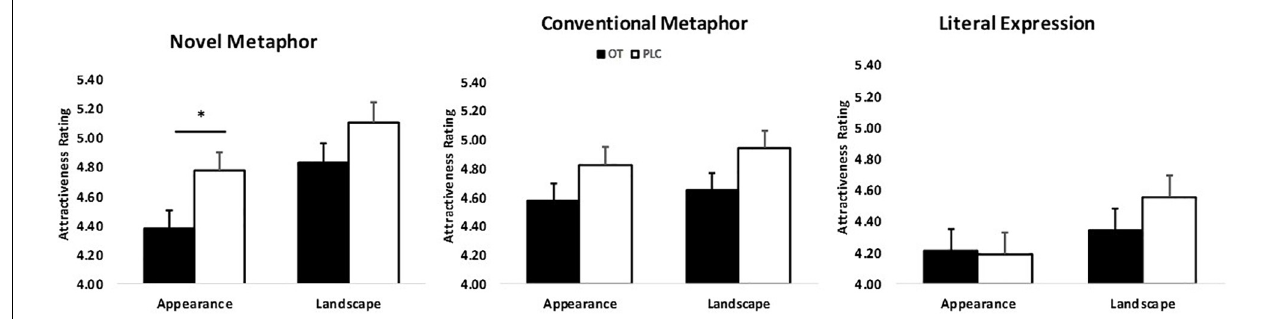
FIGURE 2 | Topic × figurativeness of men’s compliments × treatment interaction affects attractiveness ratings ( n = 62). * p < 0.05, two-tailed t -test. Bars indicate M ± SE.